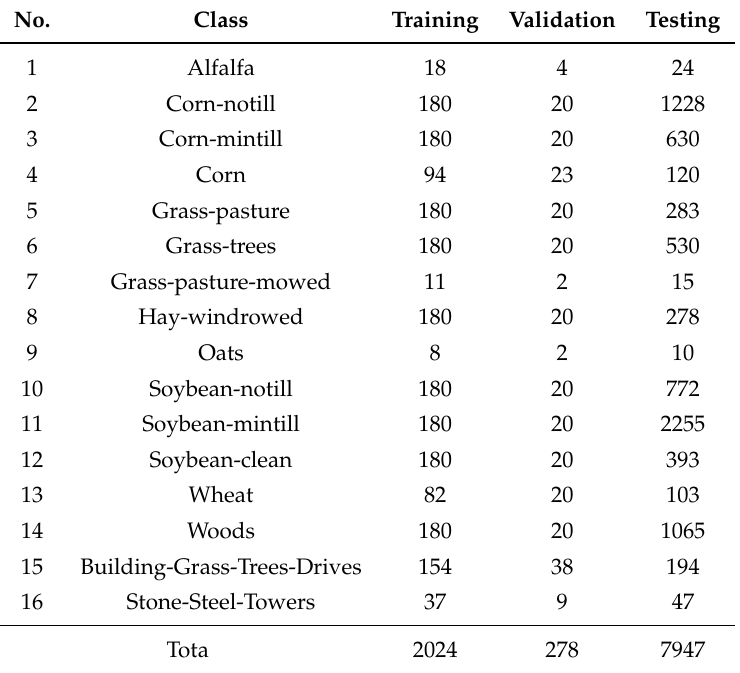
Table 2. Statisticsof Training pixels, Validation pixels and Testing pixels for the Indian Pines DataSet. No.